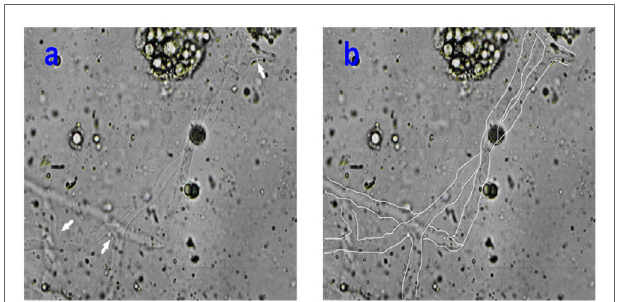
FIGURe 1 | (a,B) The pictures illustrated the non-septate wide ribbon-shape mucormycotic hyphae observed in KOH (20%) preparation under 400 × magnification. The arrows (a) indicated the rectangular divides of hyphae. The mucormycotic hyphae were drawn in white